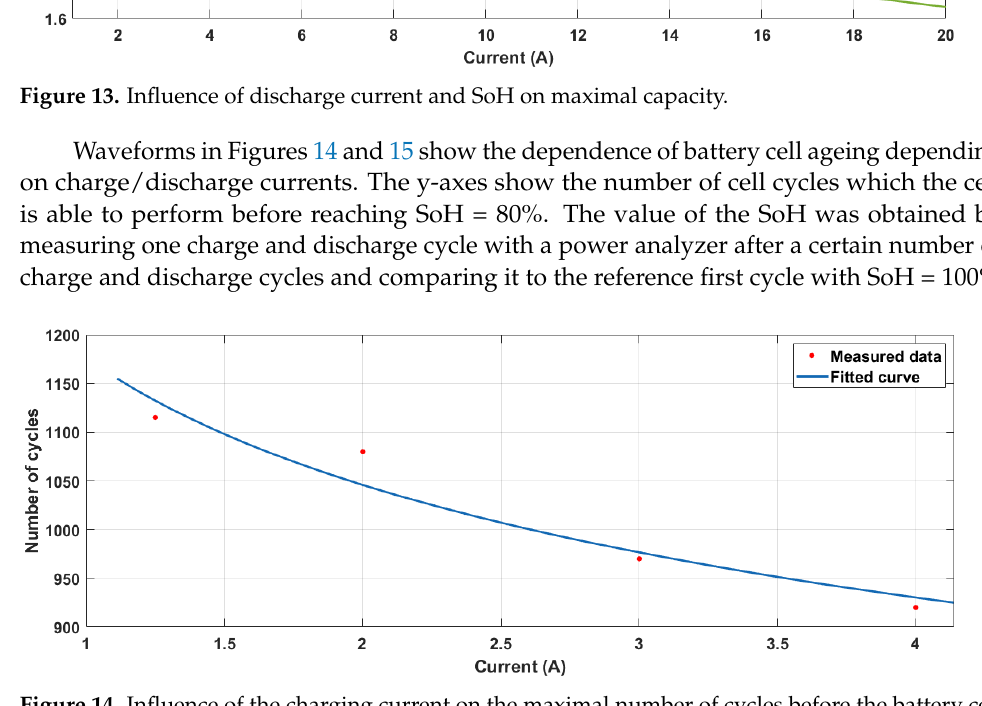
Figure 14. Influence of the charging current on the maximal number of cycles before the battery cell reaches SoH =